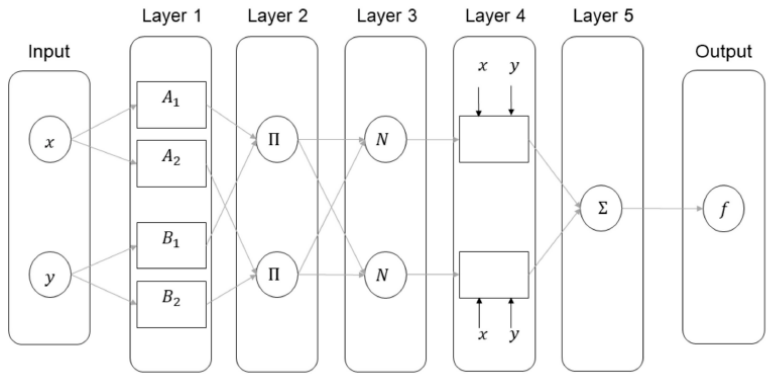
Figure 2. Structure of the ANFIS model.